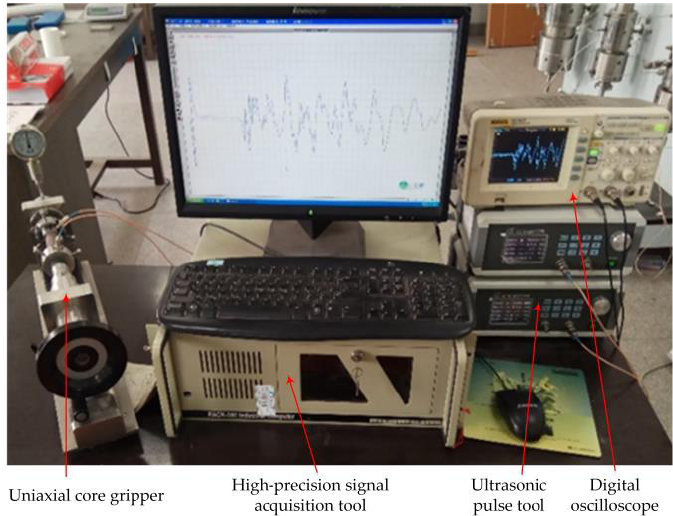
Figure 8. Photograph of the ultrasonic experimental measurement system, which mainly consists of two S-wave transducers, an ultrasonic pulse tool, a signal acquisition tool, a digital oscilloscope, and a core sample clamping device.